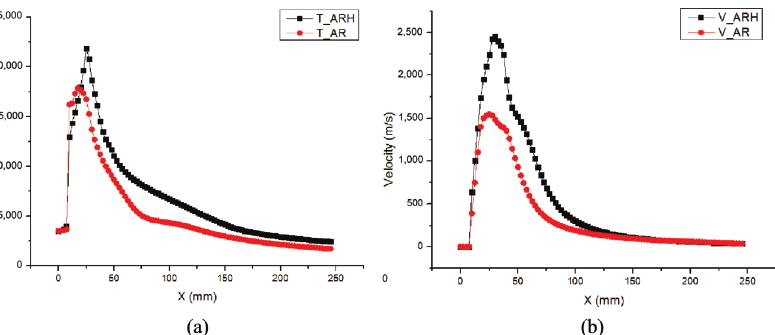
Figure 5: Temperature distribution of plasma jet in (a) axial direction and (b) radial direction at Ar þ H 2 (20 vol.%).